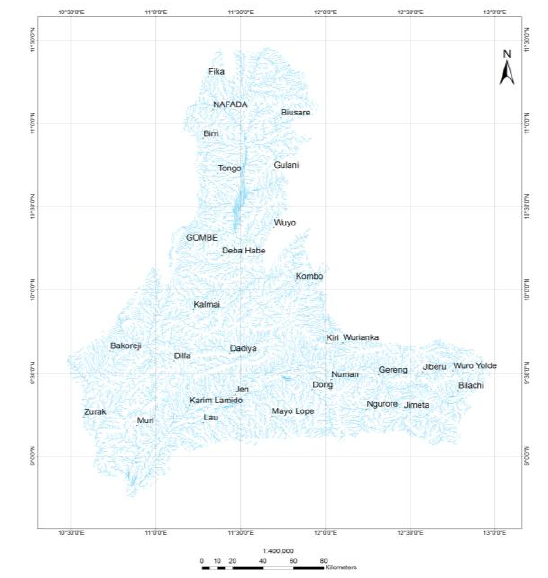
Figure 11. Drainage map of the Upper Benue Trough derived from the DEM